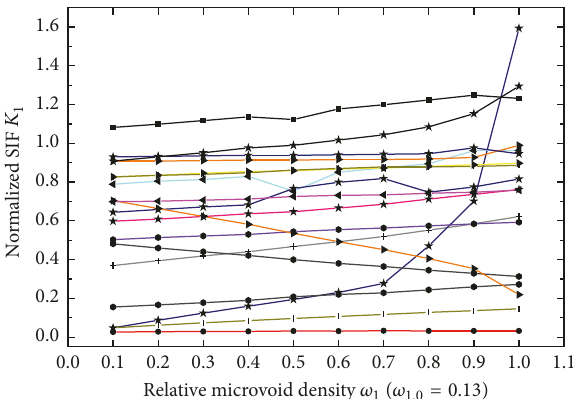
Figure 16: 𝐾 1 versus relative microvoid density when 𝜔 2 = 0.06.